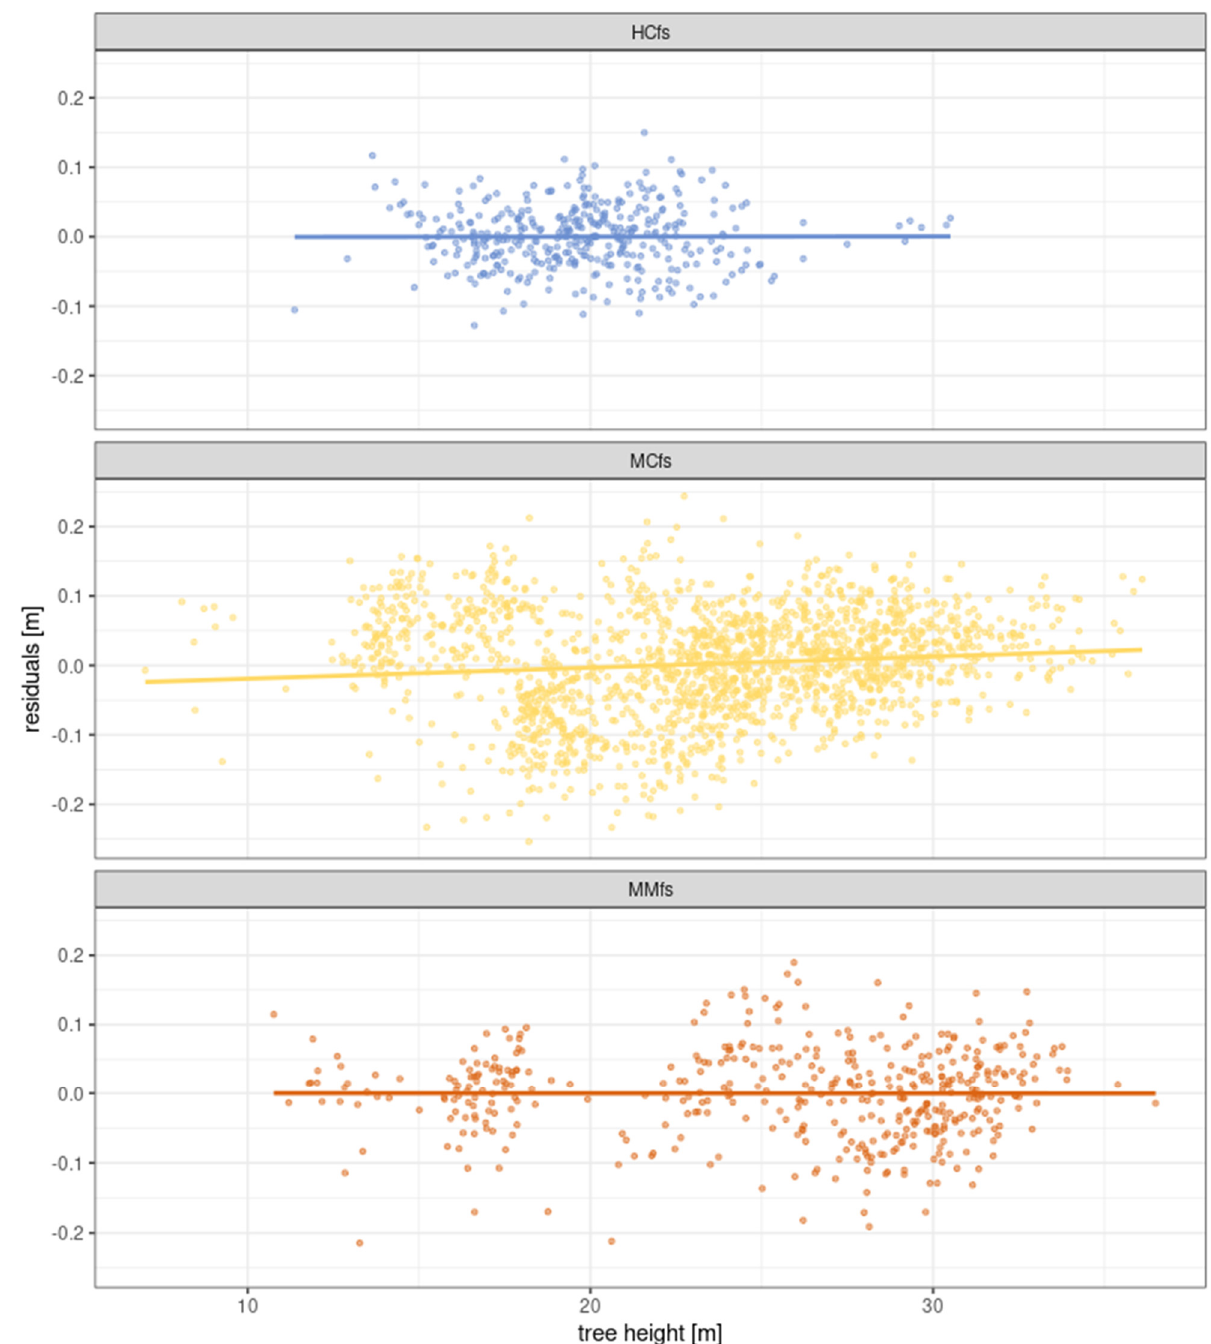
Figure 16. Residuals from the fitted function related to Gompetrz curve, an approximation of annual tree height growth based on initial tree height along with linear regression with least squares method. Slight dependence of residuals for model of Scot pines on MCfs can be noticed.